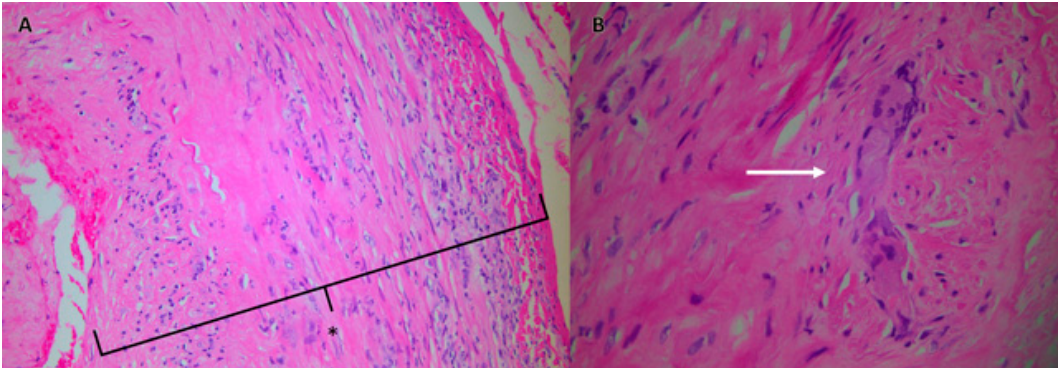
Figure 2. Histology specimen obtained from the patient’s temporal artery biopsy that was typical of temporal (giant cell) arteritis. Panel A shows an inflammatory cell infiltrate with a cuff of lymphocytes and monocytes within the adventitia, inflammation across the media with involvement of an oedematous intima (*), and presence of occasional multinucleated giant cells (Panel B , arrow).